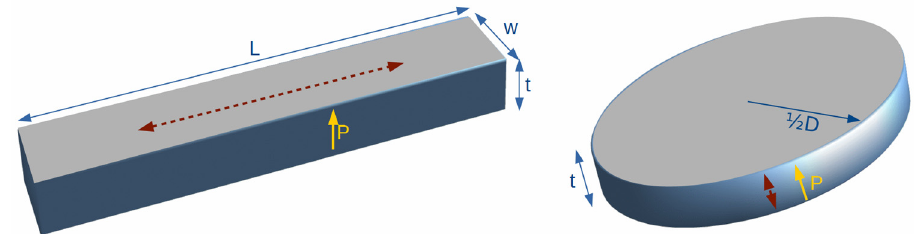
Figure 5. The two resonator geometries used in the simulation of the effect of the losses on the resonance.